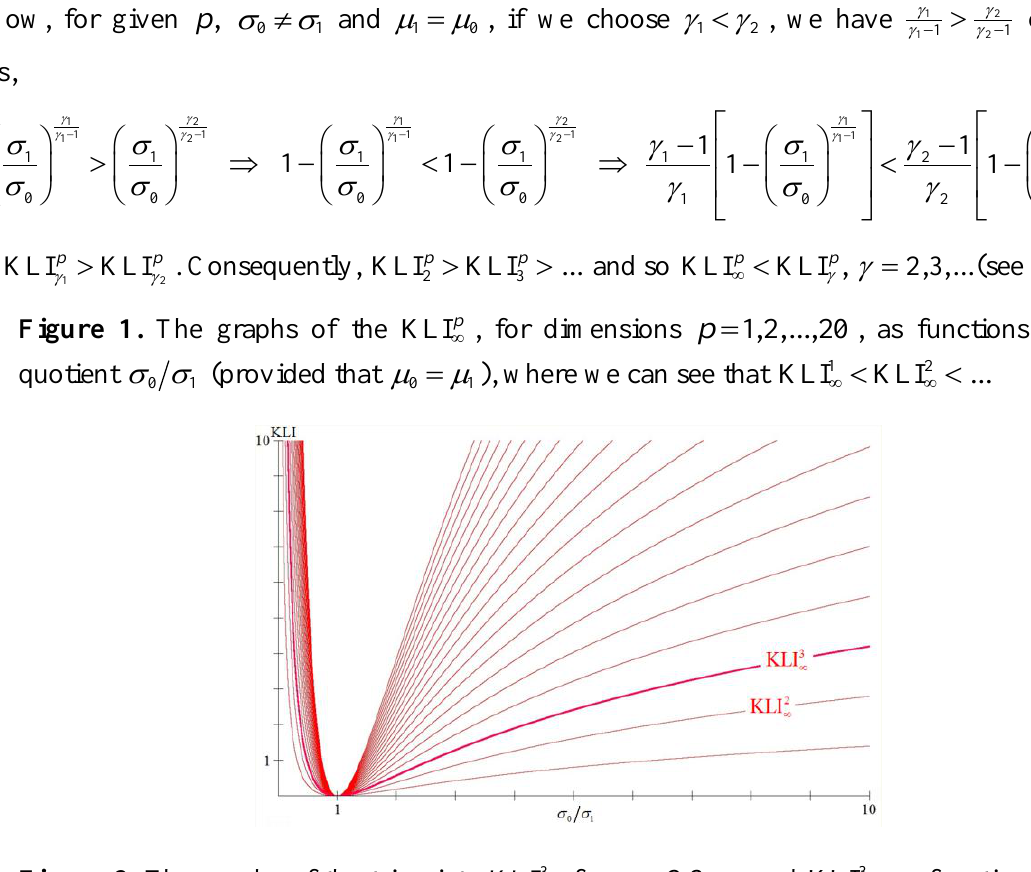
, for 2,3,...  , and 3 KLI 